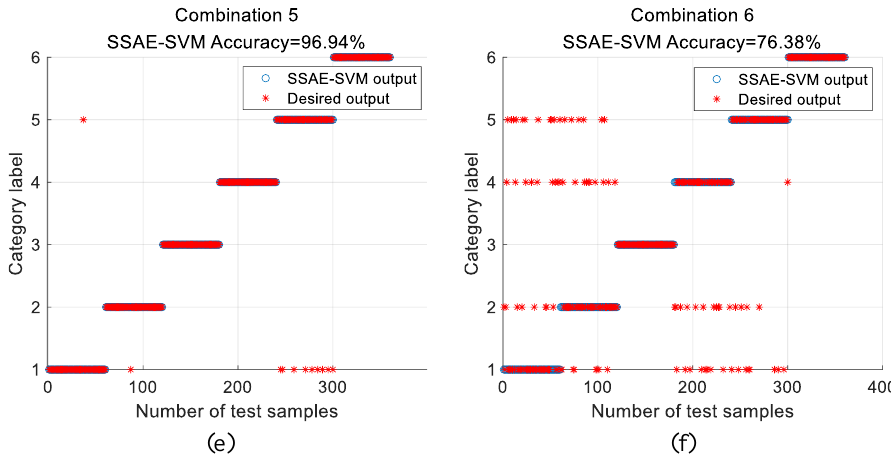
Figure 11. The SSAE-SVM diagnosis results under different sensor combinations: ( a ) Combination 1; ( b ) Combination 2; ( c ) Combination 3; ( d ) Combination 4; ( e ) Combination 5; ( f ) Combination 6. Table 8. The comparative analysis of the diagnostic results under different sensor combinations.